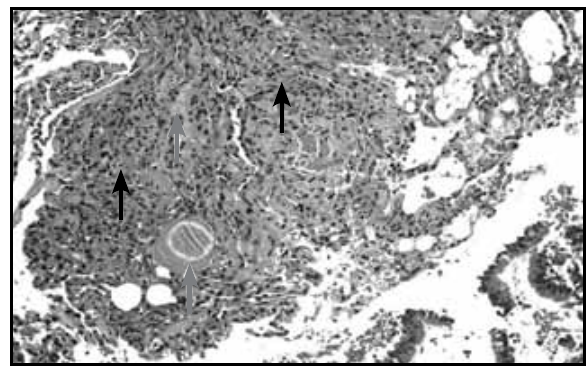
Figure 2 – Specimen from transbronchial biopsy HE (40×): the normal pulmonary parenchima contrast with the affected area that shows septal fibrosis (black arrows) and intra alveolar proteinaceous material (white